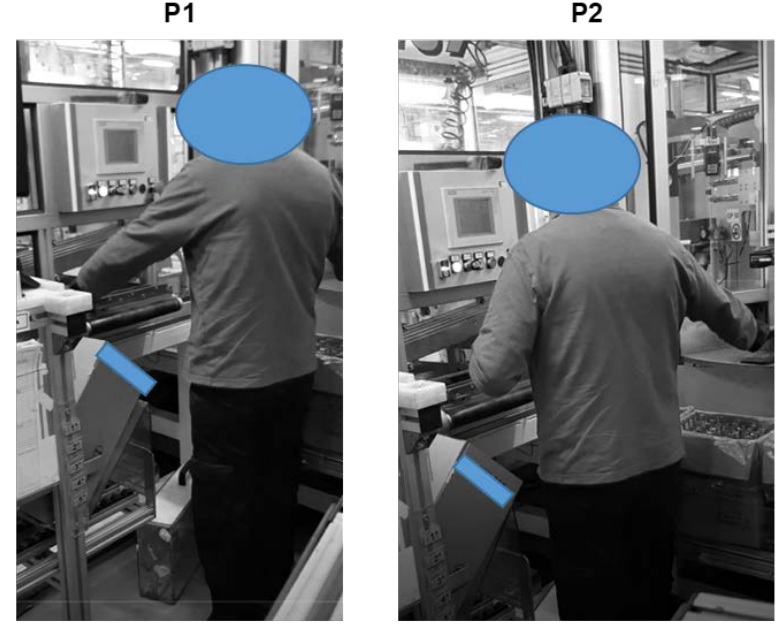
Figure 13. Critical torsion of the trunk in the Gamma workstation.